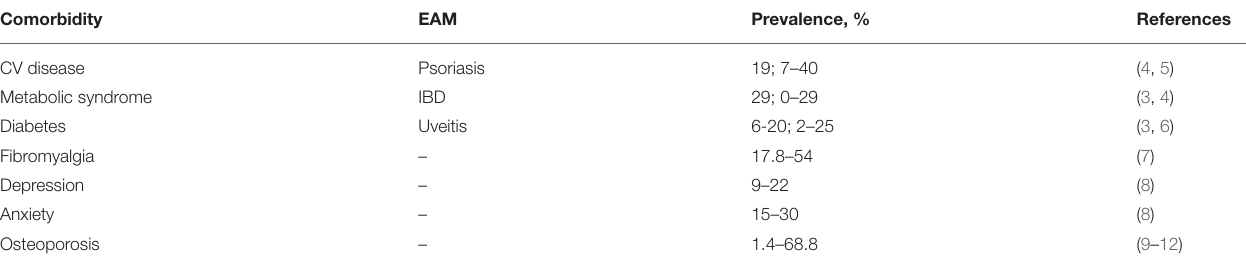
TABLE 1 | Prevalence of comorbidities and EAMs in PsA.